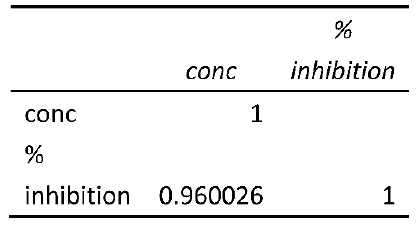
Figure 6. Shows the significant activity of the ( A ) standard doxorubicin and ( B ) W. somnifera extracts against HepG2 viable cells in the culture